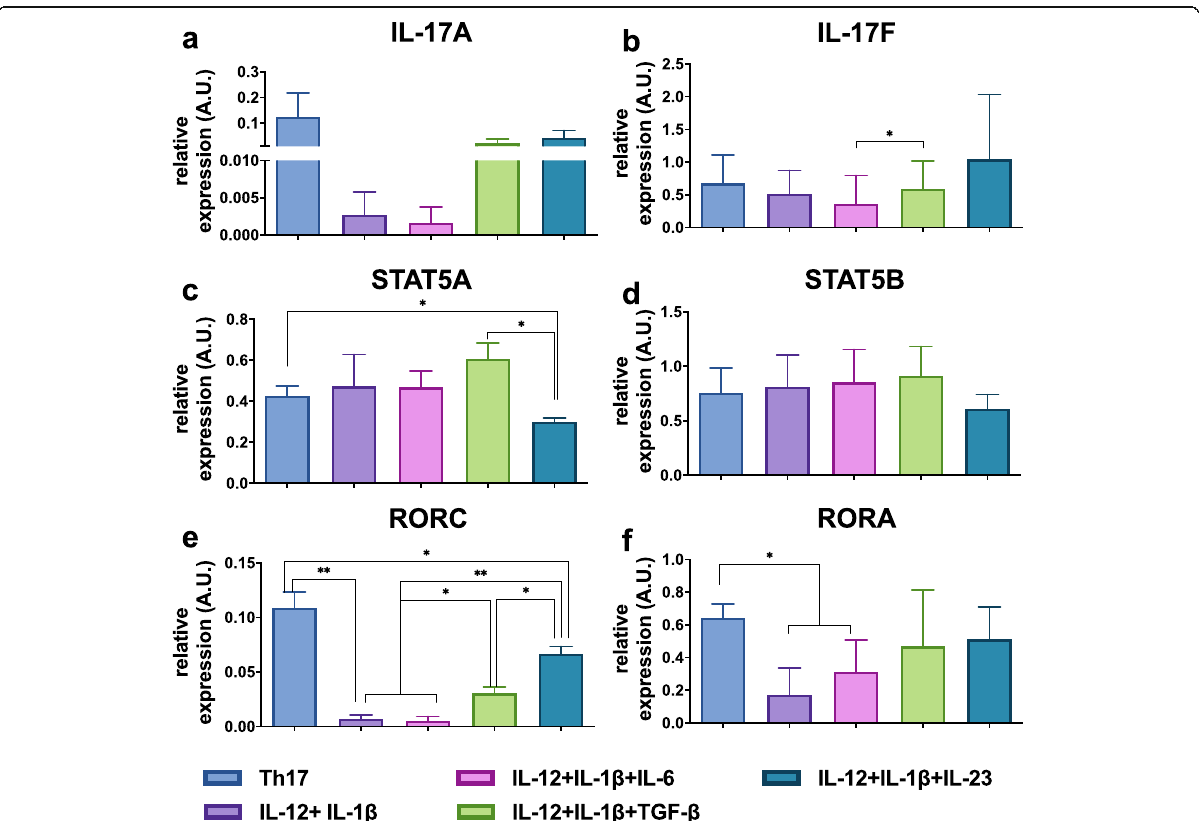
Fig. 8 Combinatorial effect of Th17 polarizing cytokines. Human naive T cells were differentiated for 5 days in the presence of polyclonal activation (anti-CD3/anti-CD28 beads). Cells were cultured in the presence of different cytokine inputs: IL-12 + IL-1 β , IL-12 + IL-1 β + IL-23, IL-1 β + IL-23, IL-12 + IL-1 β + IL-6, IL-12 + IL-1 β + TGF- β , proTh17 (IL-1 β + IL-6 + IL-23 + TGF- β ). Cells exposed only to polyclonal stimulation were considered as Th0. RNA extraction of differentiated cells was performed and transcripts were then quantified by RT-PCR. Gene expression was normalized to the reference genes HPRT1, B2M and RPL34. a Relative expression of IL-17A. b Relative expression of IL-17F. c Relative expression of STAT5A. d Relative expression of STAT5B. e Relative expression of RORC. f Relative expression of RORA. Graphs represent mean ± SD, N = 3, * and ** represents p < 0.05 and p < 0.01, respectively (paired